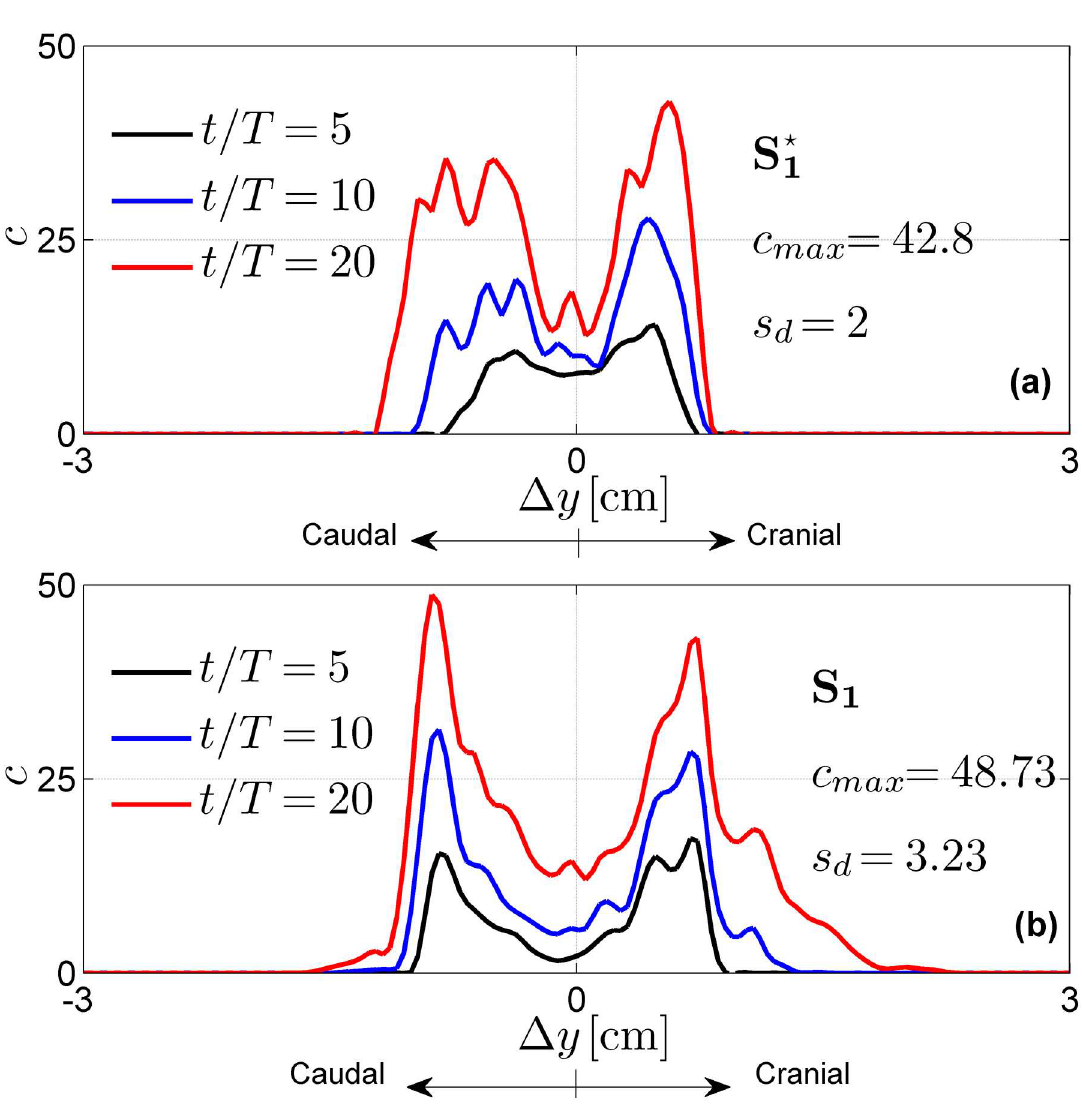
Fig 3. Normalized drug concentration profiles as a function of the distance Δ y from the injection point P 1 . The reported profilesresult from (a) S ? and (b) S 1 1